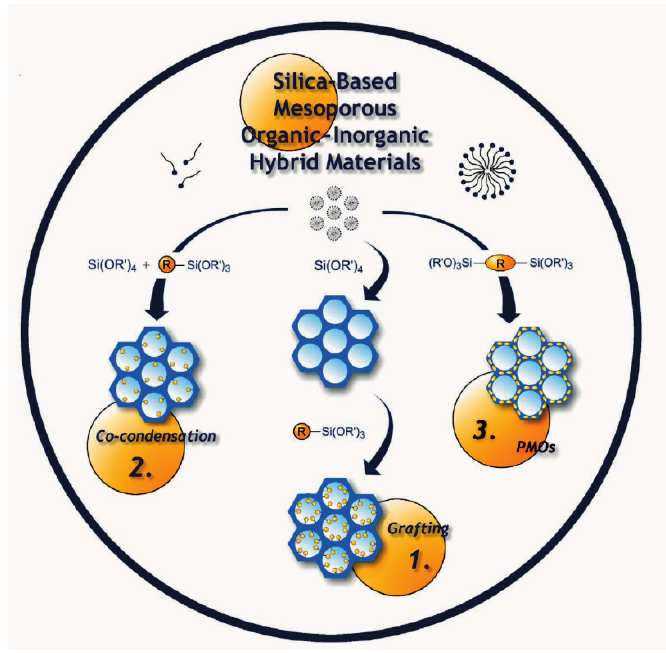
Figure 7. Schematic of three routes for preparing functionalized mesoporous silica. Reprinted with permission from